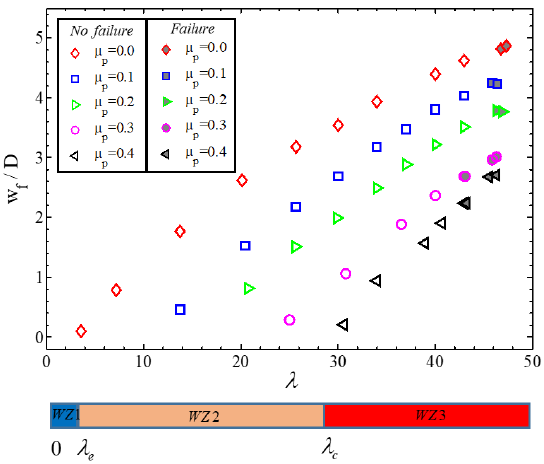
Figure 16. The correlation of the permanent displacement with the input kinematic energy and pre − stressed level (Zone for WZ1, WZ2 and WZ3 represent total elastic recovery, inelastic plastic displacement and partial or total failure, respectively).